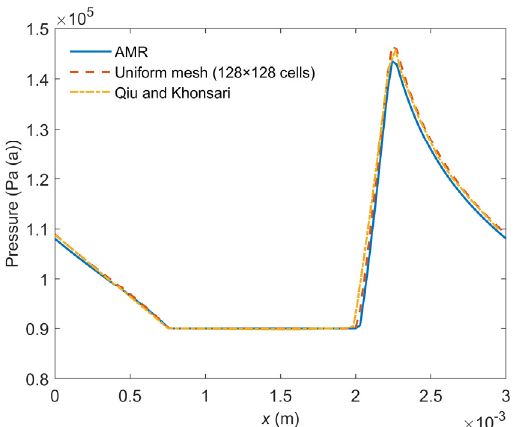
Figure 11. Final refined mesh for thrust bearing: ( a ) pressure distribution; ( b ) density ratio distribution.